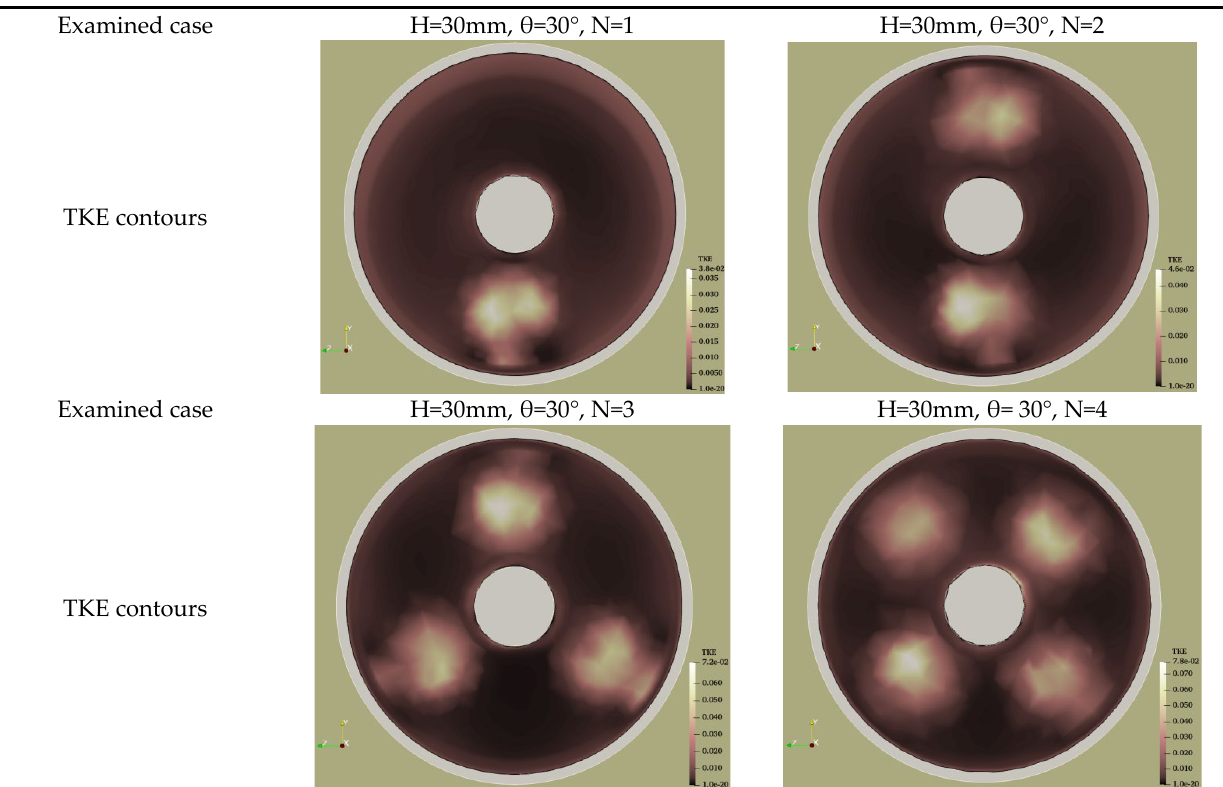
Figure 14. Effect of number of strip-inserts on the turbulent kinetic energy (TKE) distributions. Table 6. Thermal enhancement in the Nu number with single and multiple conical inserts, with and without nanofluid at Re = 10,000.